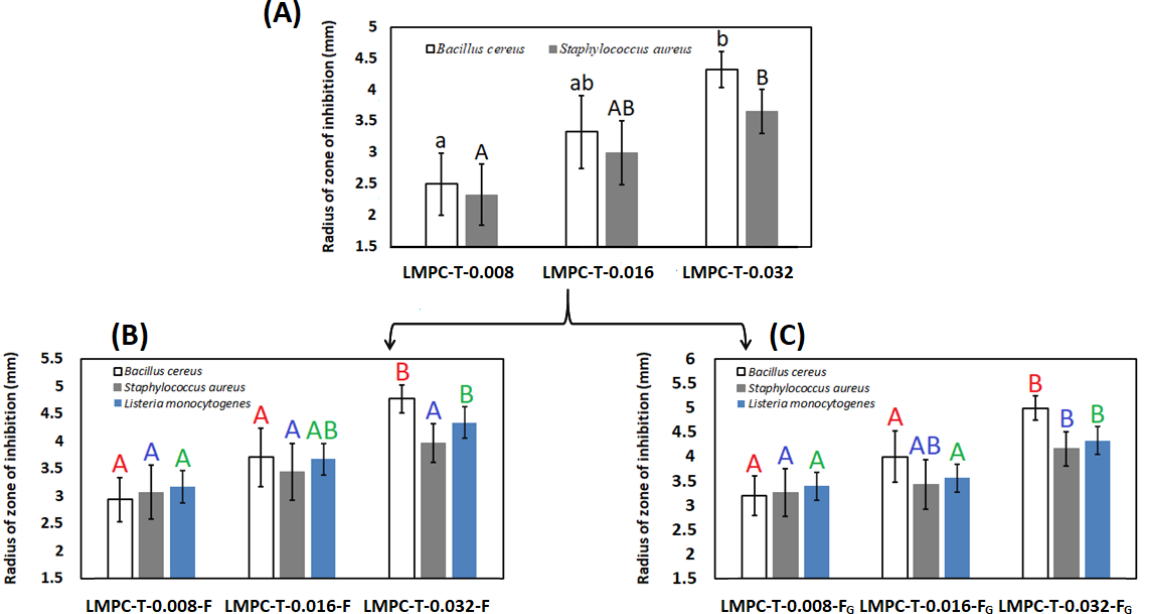
Figure 11. The zone of inhibition in mm (antibacterial activity), provided by LMPC-T ( A ), LMPC-T-F ( B ) and LMPC-T-F G ( C ). Results are represented with a mean value and standard deviation ( ± values) of three triplicate experimental results. In superscript, a dissimilar alphabet represents a significant difference between results.